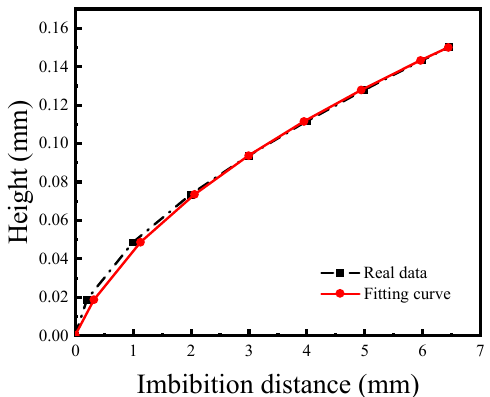
Figure A2. The curves of the height of cross section as a function of imbibition distance (the black curve is obtained according to Equations (A1) and (A2), the red one is a fitting curve). The expression of the fitting curve is shown in Equation (A3):